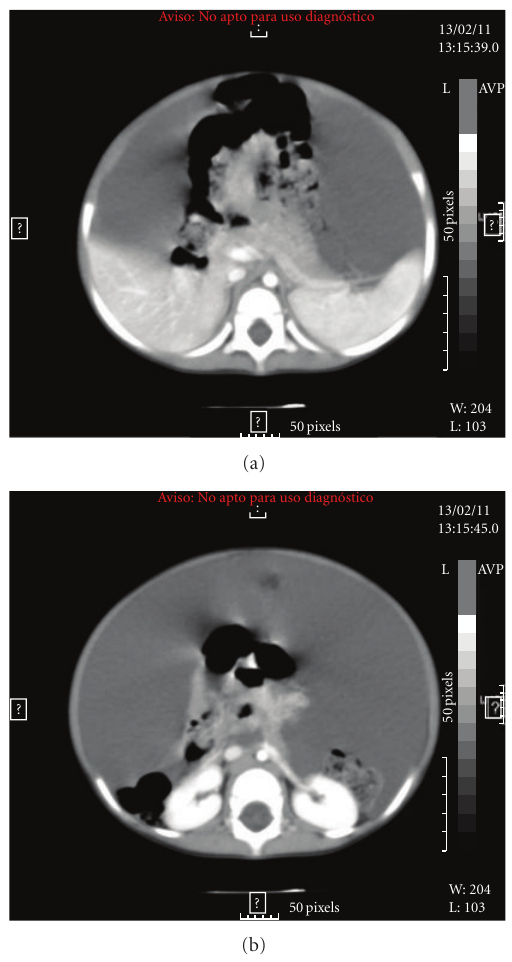
Figure 2: Bleeding tension, displacing abdominal organs.